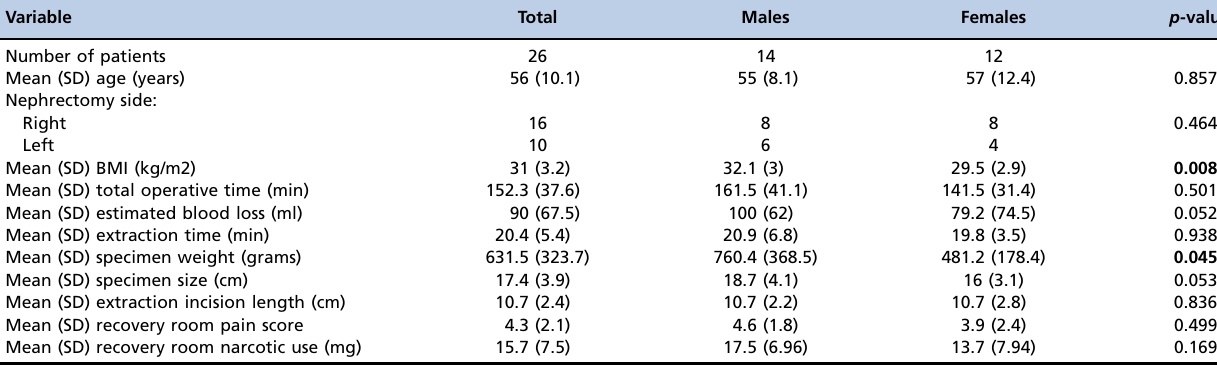
Table 1 - Perioperative patient, surgery and specimen characteristics.